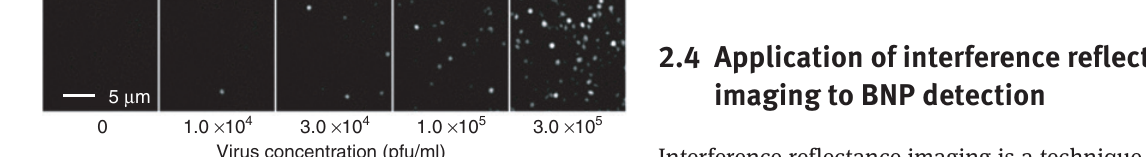
virus concentration in the sample. As seen in Figure 2, virus particles appear on the glass surfaces as diffraction- limited spots [31].